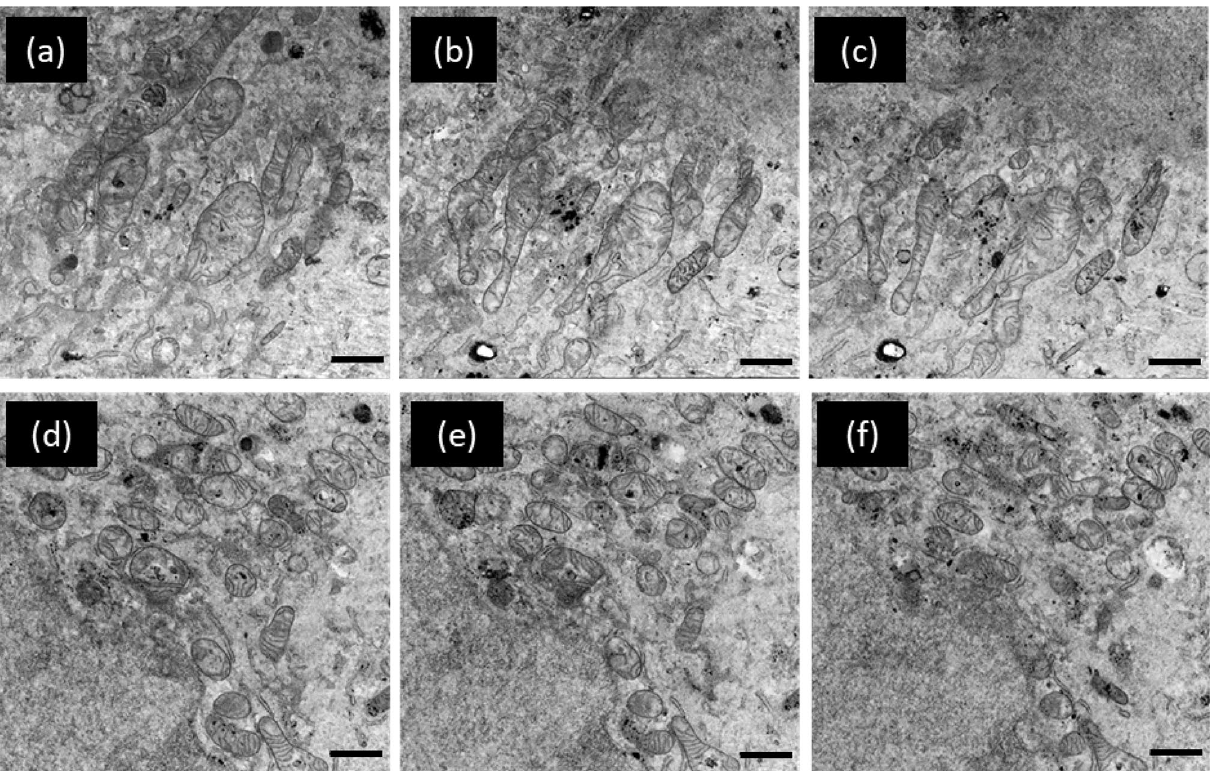
Figure 6. Select SEM images of slices of nominal 5 nm thickness taken from the OSSM data set on targeted cells. Images ( a – c ) are one subset of cells at slice 35, 55, 75. Images ( d – f ) are a second subset of cells imaged on the same slice as ( a – c ) Scale bar: 1